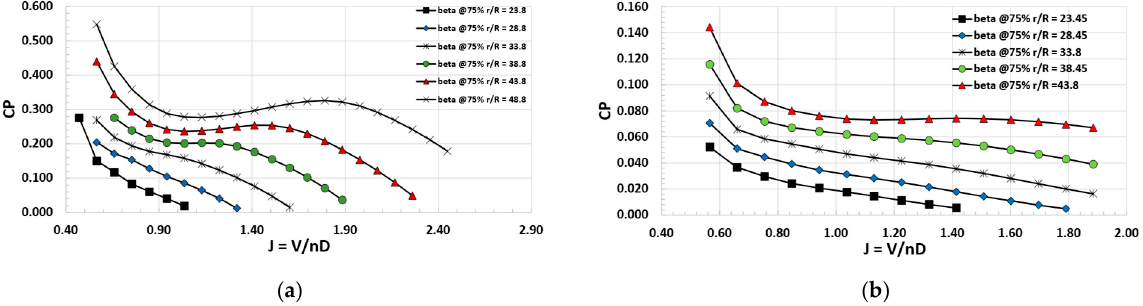
Figure 13. Propeller power coefficient map (different blade pitch angles). ( a ) Tip propeller. ( b ) DEP propeller.